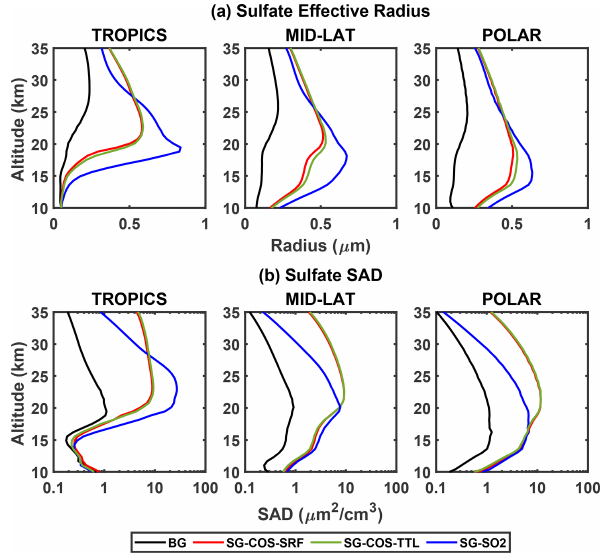
Figure 4. Vertical profiles of sulfate effective radius (in µm; a ) and surface area density (in µm 2 cm − 3 ; b ) at different latitudinal bands (20 ◦ N–20 ◦ S for the tropics, 30–50 ◦ at both N and S for the mid- latitudes, and 60–90 ◦ at both N and S for the polar plots). All quan- tities are annually averaged over the years